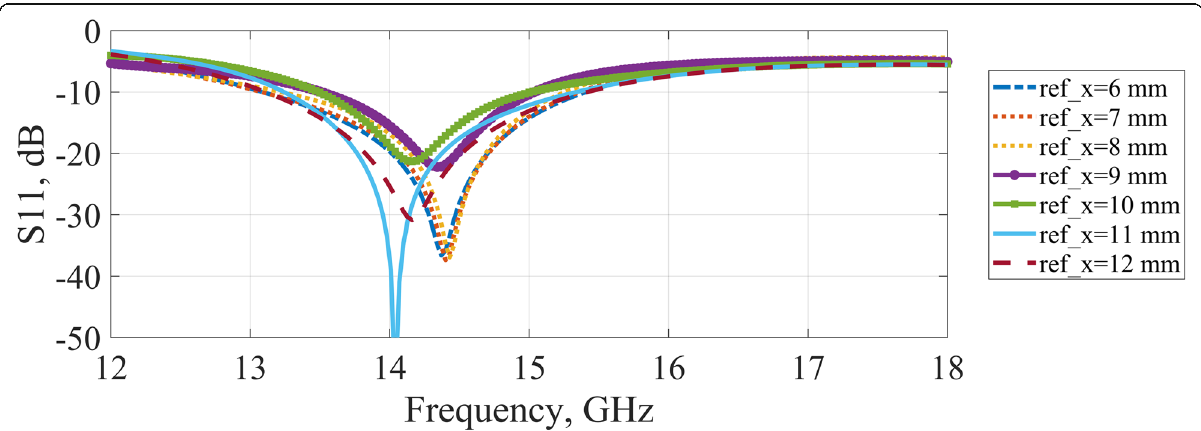
Fig. 4 Effect of the variation of ref_x on S11 frequency response